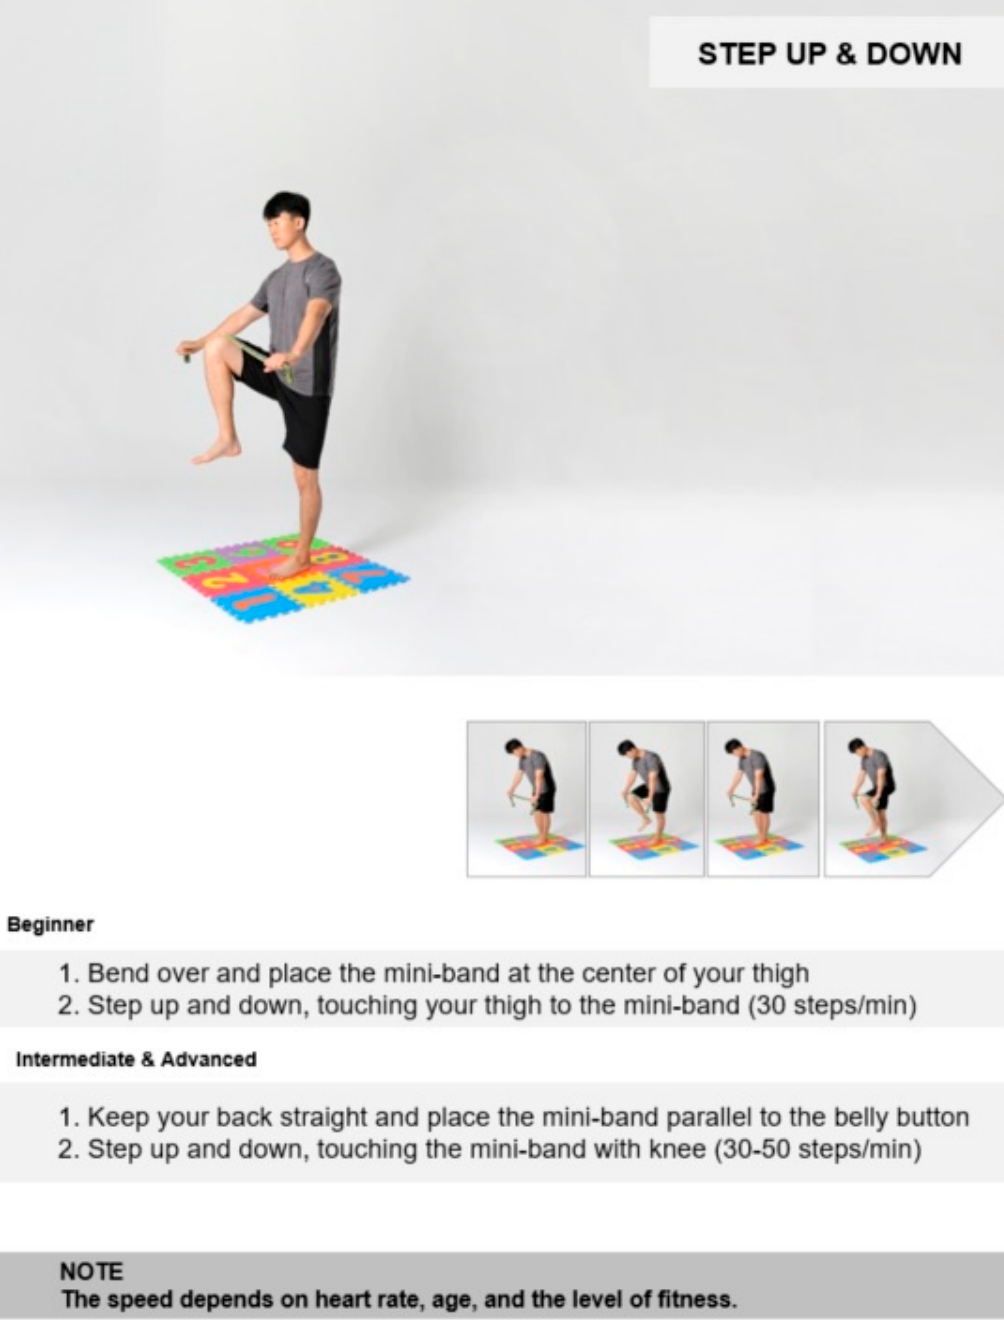
Figure A6. Detailed description and components of each movement in the “Step up and down” aerobic exercise.